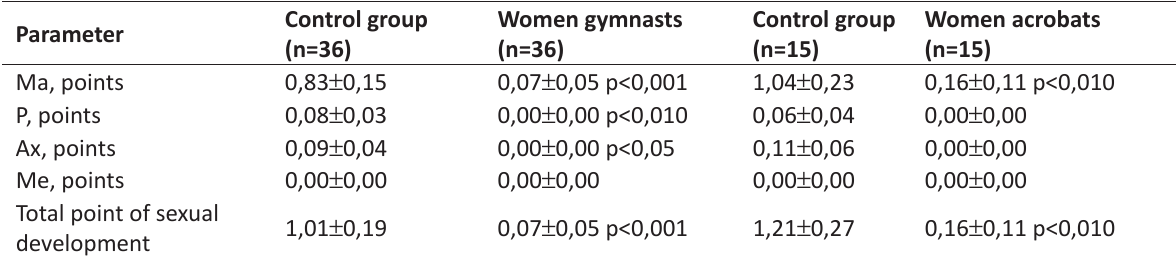
Table 2 Statistically significant differences of parameters (M±m) of 10-year-old athletes and non-athletes sexual